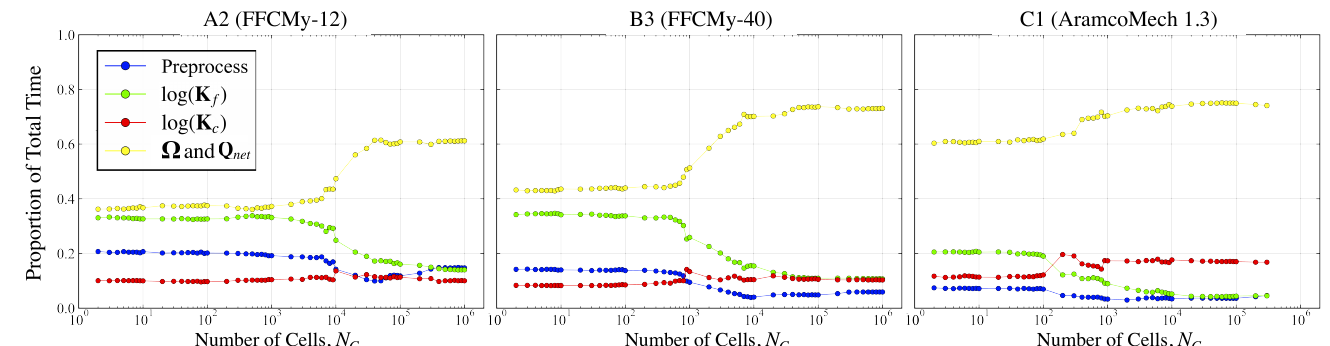
Figure 9. Computational budget (routine time normalized by total compute time) for the preprocessing routine (Component 1, blue curve), forward rate constant routine (Component 2, green curve), equilibrium rate constant rou- tine (Component 3, red curve), and net production rate routine (Component 4, yellow curve). The results are shown for the same three mechanisms as in Figure